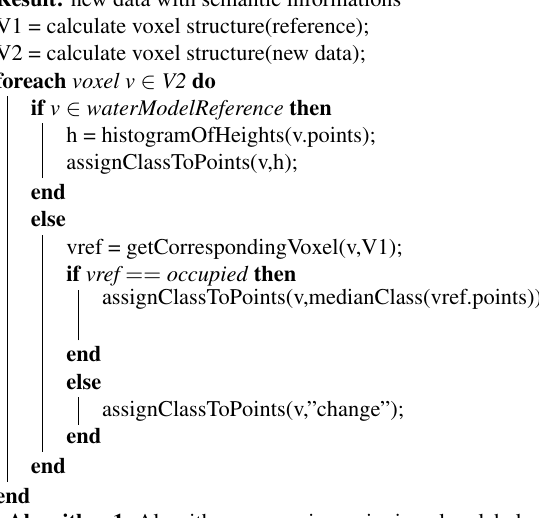
Algorithm 1: Algorithm summarise assigning class labels